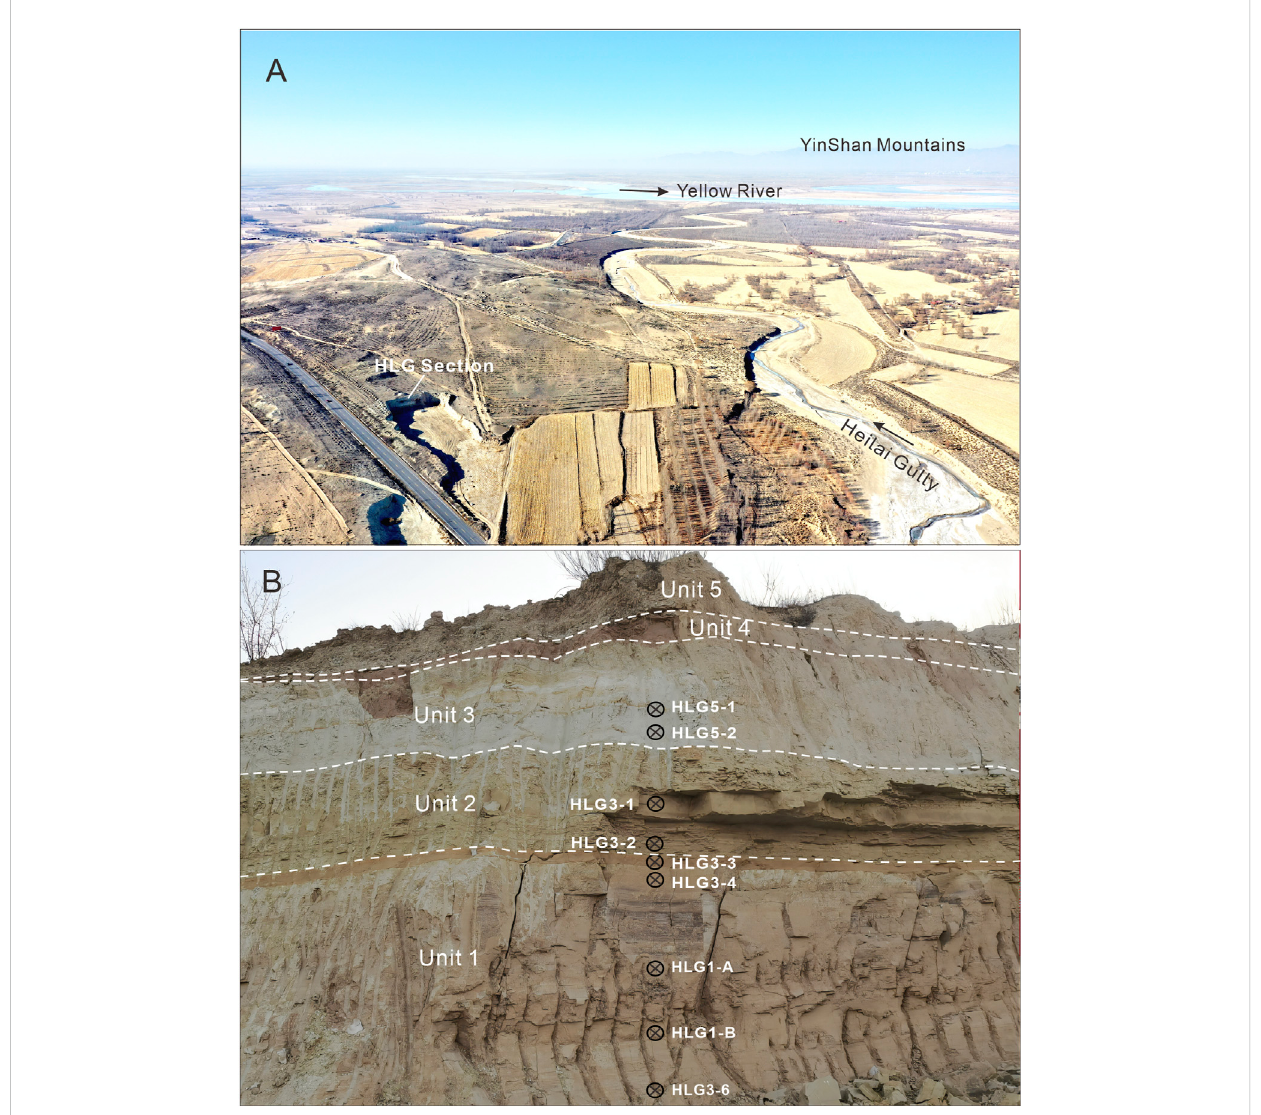
FIGURE 2 (A) Overview of modern environment in the study region; the Yellow River is 3 km north of the HLG section. (B) Stratigraphy and sampling locations of HLG